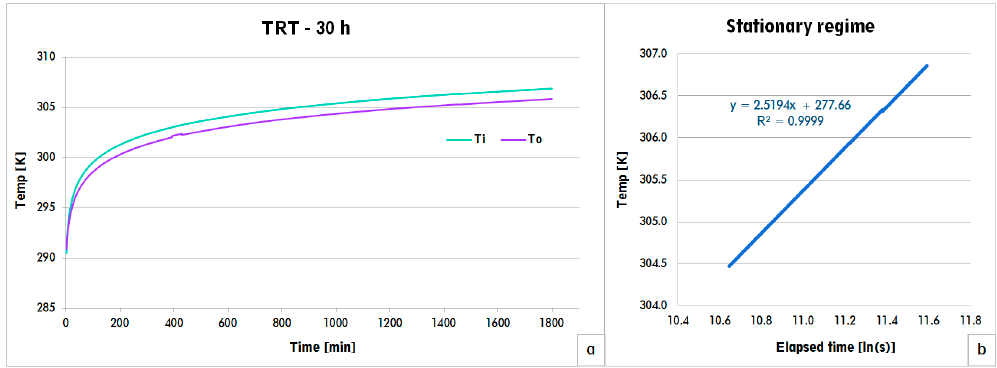
Figure 5. ( a ) TRT results for the time lapse of 30 h, ( b ) stationary regime considering 1100 sampling values.